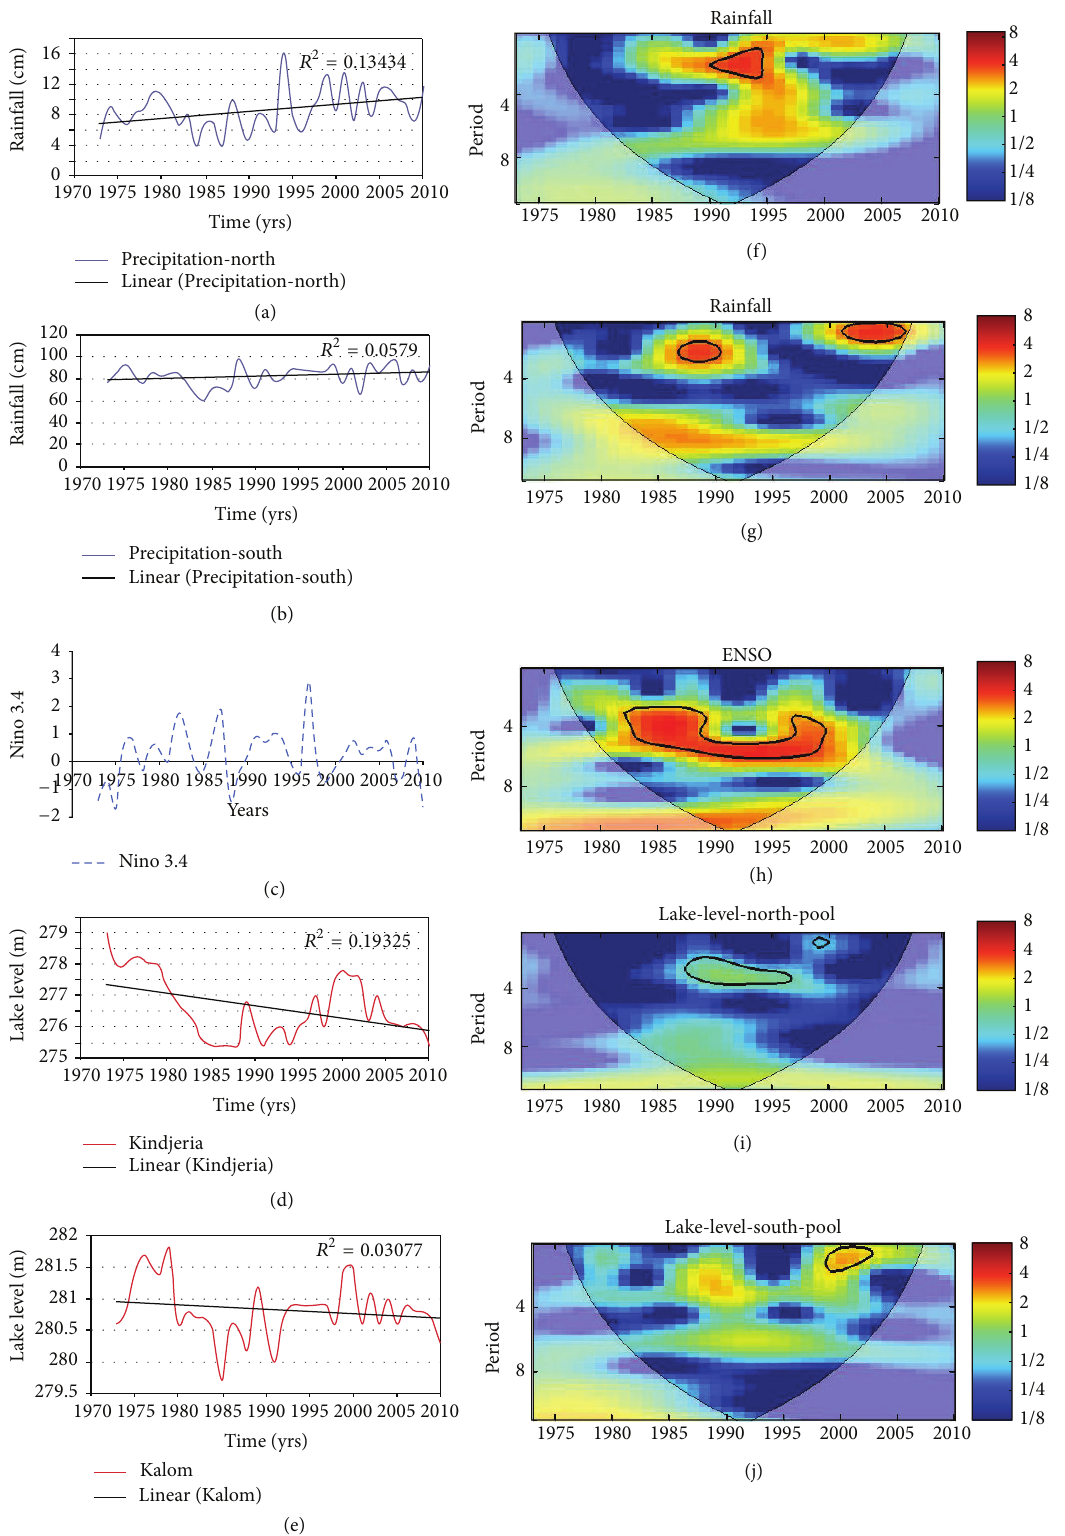
Figure 4: Standardized time series (left) of (a) rainfall in the northern LCB, (b) rainfall in the southern LCB, (c) ENSO, (d) LC level at Kindjeria, and (e) LCL at Kalom and their respective continuous wavelet transforms (f), (g), (h), (i), and (j) (right). The thick contour enclosed regions are greater than 95% confidence for a red-noise process. The thin solid line indicates the “cone of influence,” where edge effects become